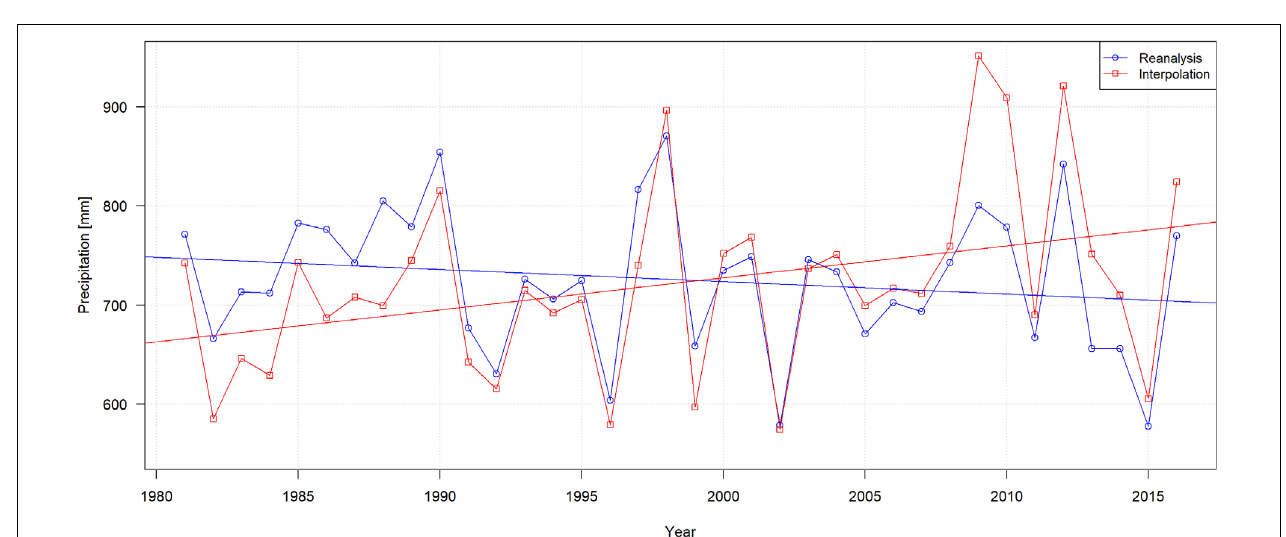
FIGURE 5 | Comparison of annual mean precipitation (RR) obtained by interpolation of station data and reanalysis ECMWF ERA-Interim.